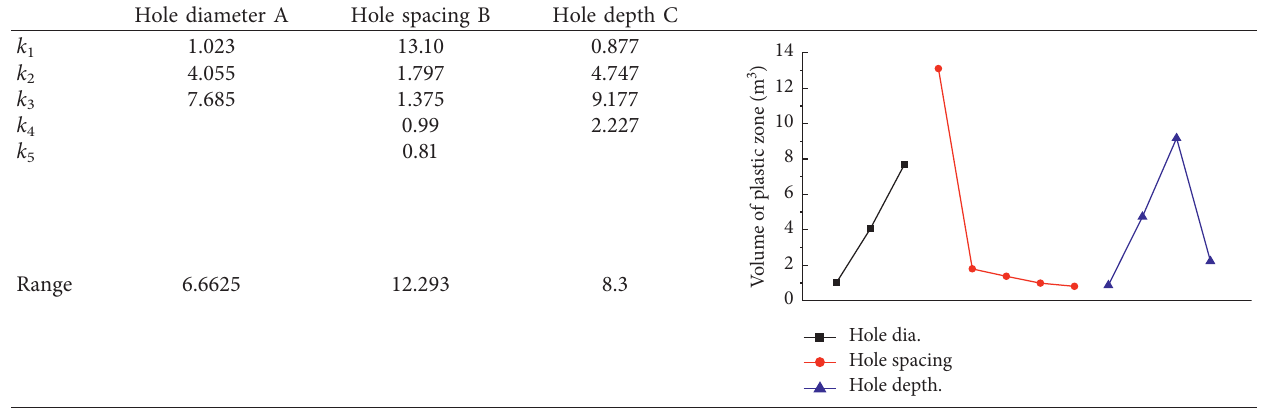
Table 10: Range for volume of plastic zone Δ U of each model.